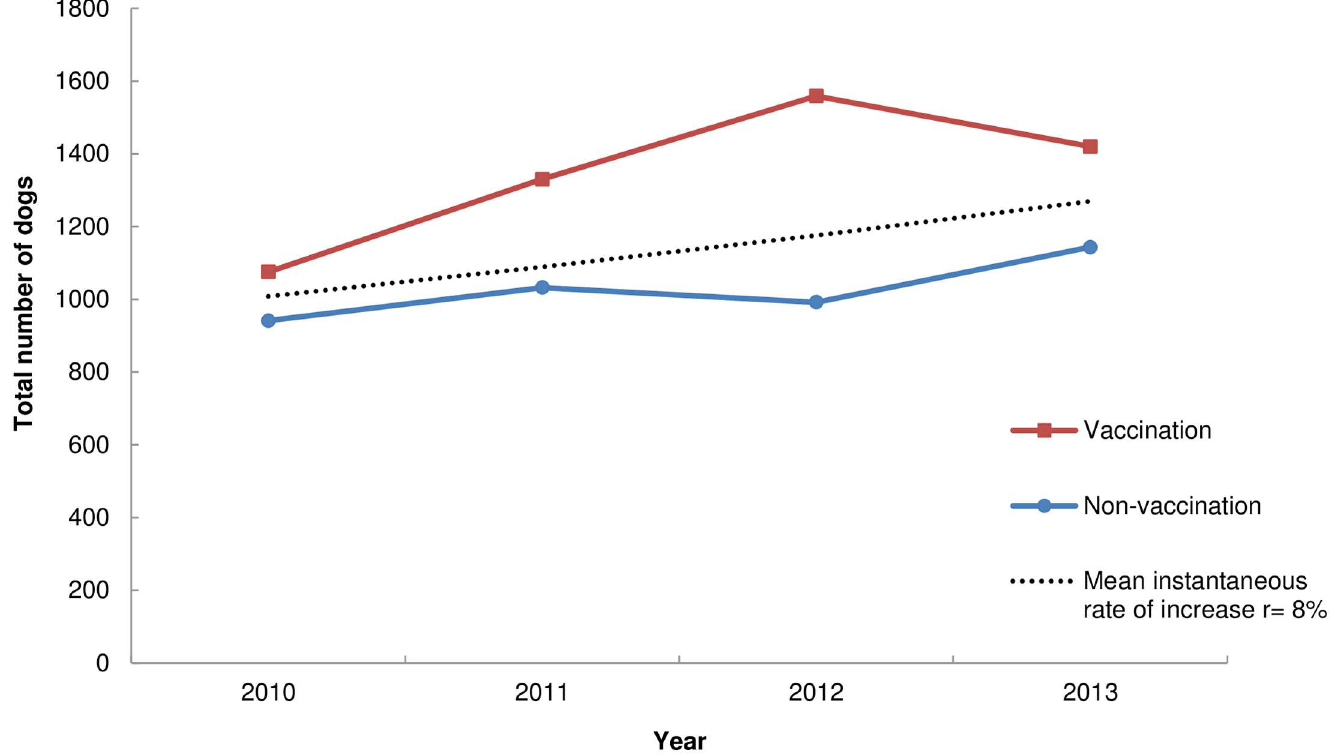
Fig 8. Total number of dogs recorded each year of the study in each village census. The blue line represents the non-vaccination villages(Buyubi and Iyogelo)and the red line representsthe vaccinationvillages(Nangaleand Sanungu). The trendlineindicatesthe mean predicted instantaneous rate of increase(r = 0.08 per year) between2010 and 2013in all villages.